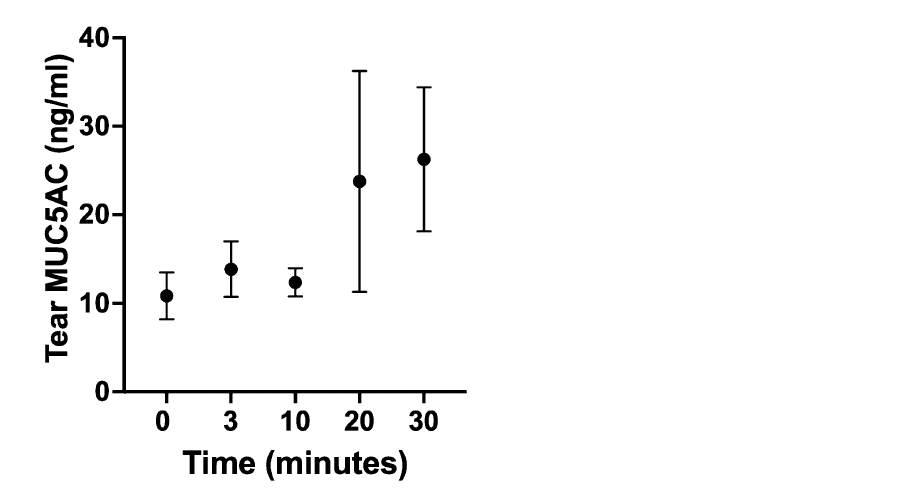
Figure 2. Changes in MUC5AC concentrations in rabbit tear samples after continuous eyelid opening. After 20 min of exposure, the tear MUC5AC level was doubled as compared to that at baseline ( p = 0.007, Friedman test).